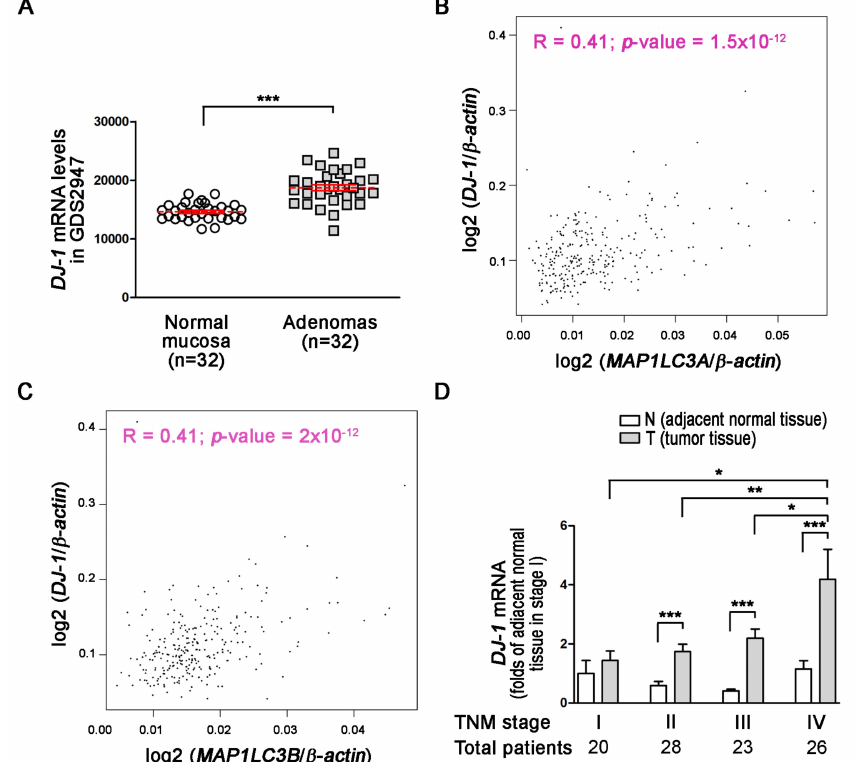
Figure 1. DJ-1 mRNA overexpression in tumor tissues (T) but not adjacent normal tissues (N) is positively correlated with TNM stages of colorectal cancer patients, and DJ-1 (cid:48) s function may associate with autophagy/mitophagy. ( A ) The microarray analysis result of the GSD2947 dataset shows that DJ-1 mRNA levels were higher in colorectal adenoma than normal mucosa in 32 pairs of tissues from 28 colorectal cancer patients of Belcolle City Hospital (Viterbo, Italy). Data are expressed as the means ± S.E.M; the Student’s t -test determined the p -value. ***: p < 0.001 compared with normal mucosa. ( B ) The analysis result of GEPIA (Gene Expression Profiling Interactive Analysis) shows DJ-1 mRNA expression was positively corrected with MAP1LC3A mRNA expression (R = 0.41). ( C ) The analysis result of GEPIA shows DJ-1 mRNA expression was positively corrected with MAP1LC3B mRNA expression (R = 0.41). The Pearson correlation coefficients determined the correlation of two gene expressions. ( D ) The real-time quantitative PCR result of 20 pairs of tissues from Taiwanese patients with TNM stage I colorectal cancer shows that DJ-1 mRNA did not significantly change between adjacent normal tissues (N) and tumor tissues (T). In tissue pairs of TNM stage II ( n = 28), III ( n = 23), and IV ( n = 26) colorectal cancer patients, DJ-1 mRNA significantly increased in T than N. In addition, the increase of DJ-1 mRNA showed TNM stage-dependent. It indicates DJ-1 mRNA overexpression in tumor tissues is positively correlated with TNM stages of colorectal cancer patients. Data are expressed as the means ± S.E.M; the p -value was determined by one-way ANOVA/Newman-Keuls test. *: p < 0.05, **: p < 0.01, ***: p < 0.001 compared with the respectively